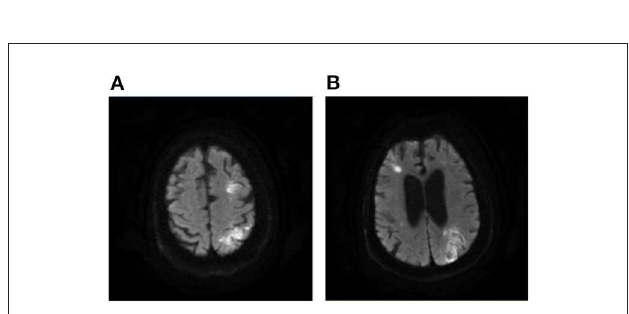
FIGURE9 A case of septic shock related AMIMCT. A 77-year-old man who experienced septic shock presented with multiple infarctions located at the bilateral internal border zones and left cortical border zone (A, B) . AMIMCT, acute multiple infarcts in multiple cerebral